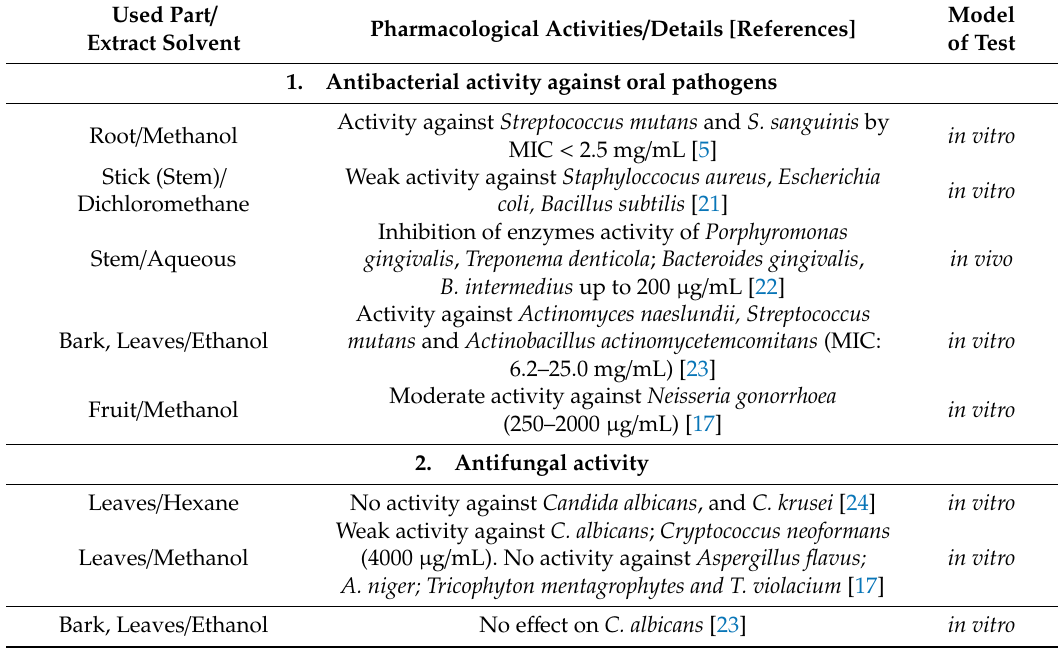
Table 1. Summary of previous biological and pharmacological studies of Euclea divinorum